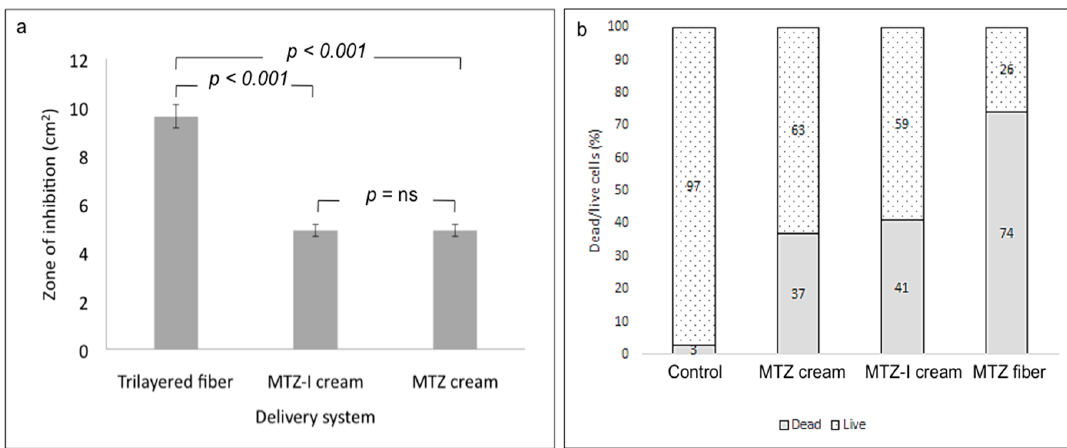
Figure 7. ( a ) Growth inhibition zone area of P. aeruginosa following 24-h incubation on LB agar plates with various drug formulations. ( b ) Dead/live cell count by flow cytometry of cell suspensions incubated for 24 h with drug-loaded fiber and cream samples.